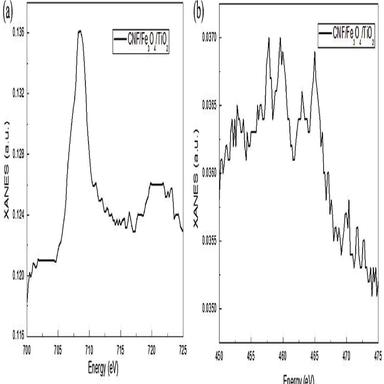
Chemical species of iron and titanium determined by Fe and Ti L3-edge TEY in the CNF/Fe3O4/TiO2 sample, respectively. (a) Chemical species of iron. (b) Chemical species of titanium.